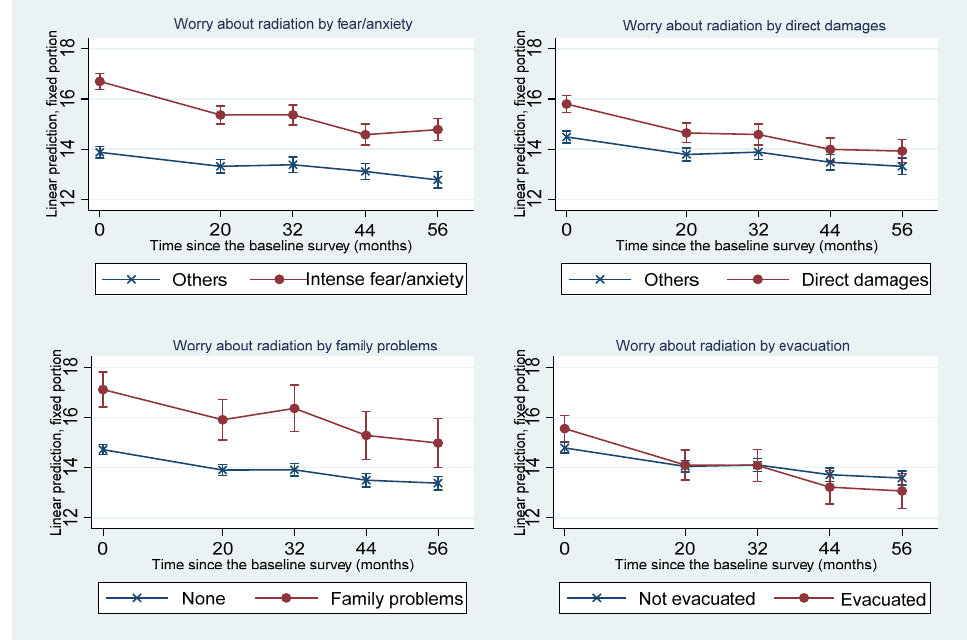
Figure 3. Changes of the adjusted predicted means of worry about radiation and 95% confidence intervals of those with and without each disaster-related experience.